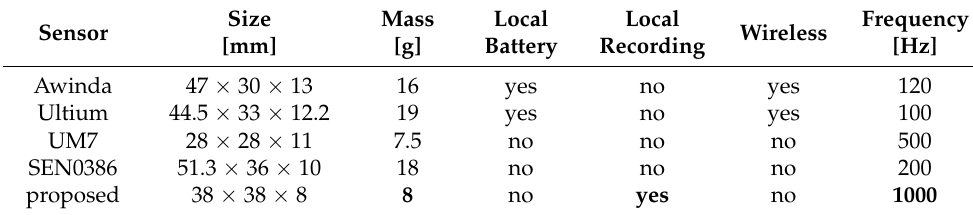
Figure 10. The example output of the synchronization procedure in Python. The comparison of different sensors presented above with the proposed sensor is shown in Table 1. Wireless sensors, Xsens Awinda and Noraxon Ultium, are much more